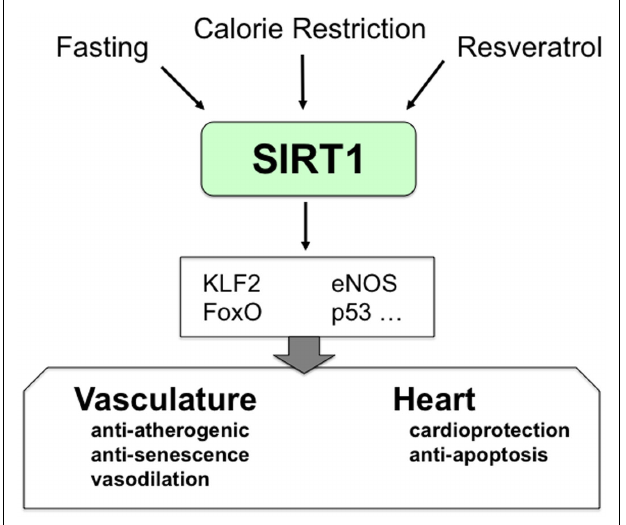
FIGURE 1 |The role of SIRT1 in vasculature. SIRT1 mediates important cellular processes in cardiovascular systems. Calorie restriction and resveratrol enhance SIRT1 expression and activity. SIRT1 modulates cellular responses in cardiovascular systems by regulating the activity of several transcription factors.